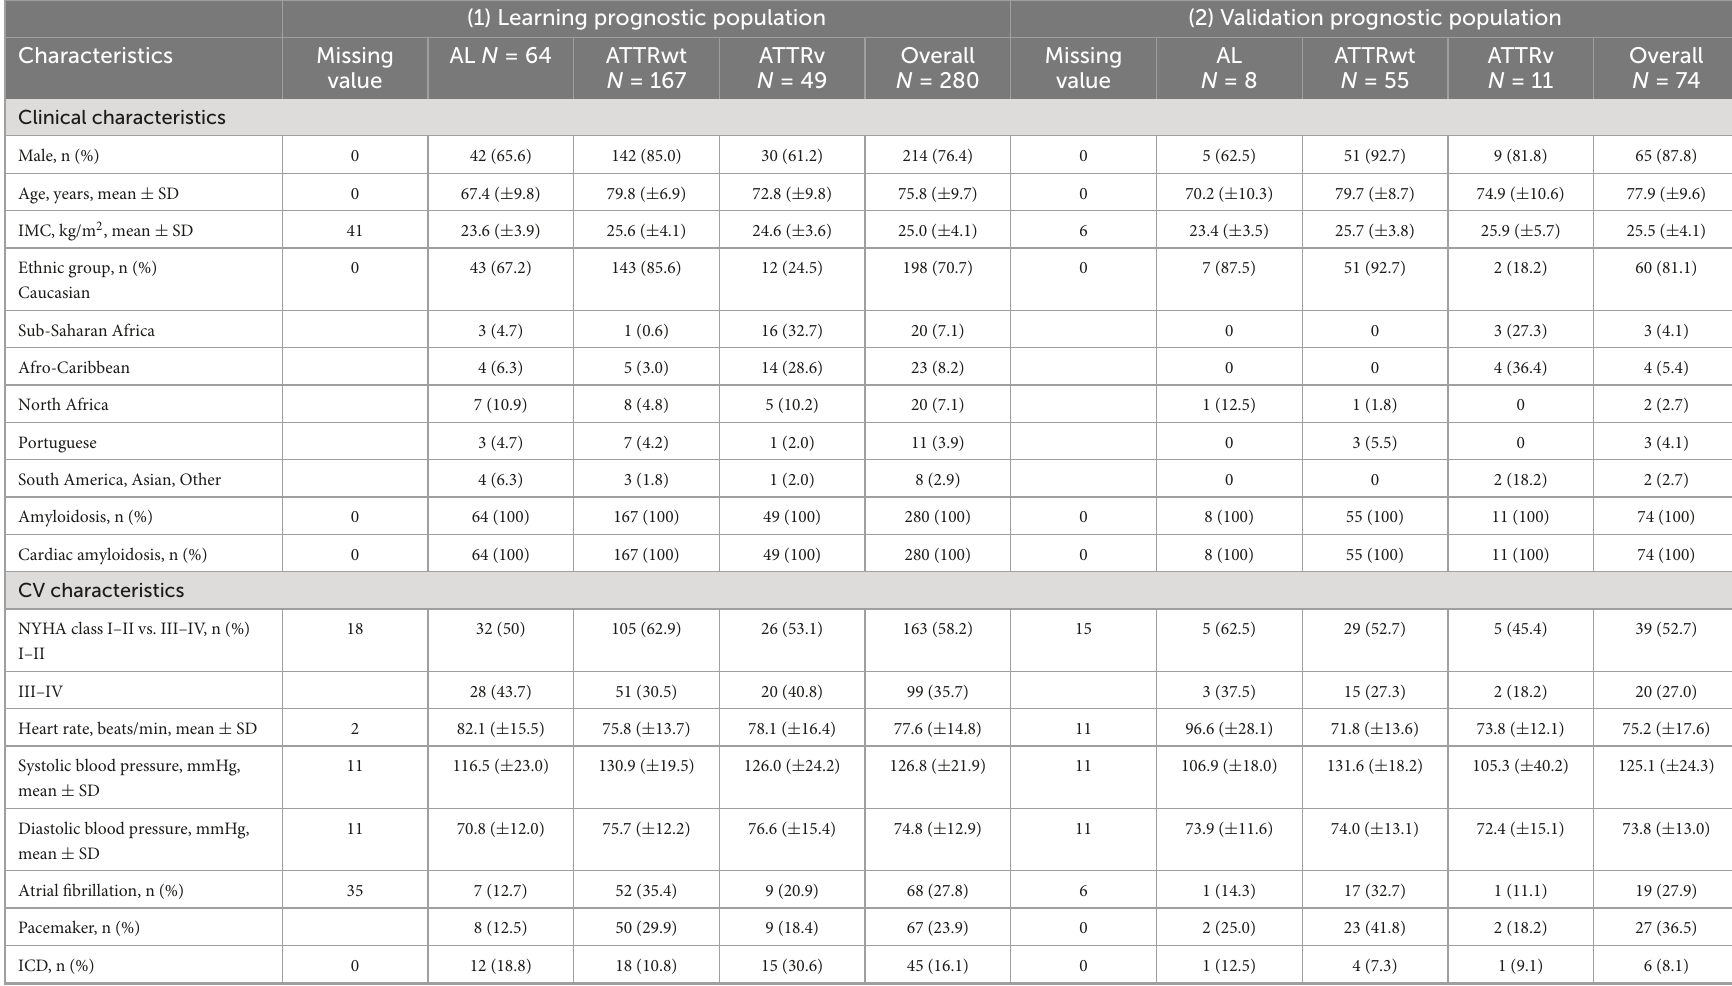
TABLE 2 Characteristics of (1) learning and (2) validation prognostic population used for the assessment of Amylo-AFFECT prognostic value, according to the type of amyloidosis: immunoglobulin light-chain amyloidosis (AL) and wild type and hereditary amyloidosis (ATTRwt and ATTRv). (1) Learning prognostic population (2) Validation prognostic